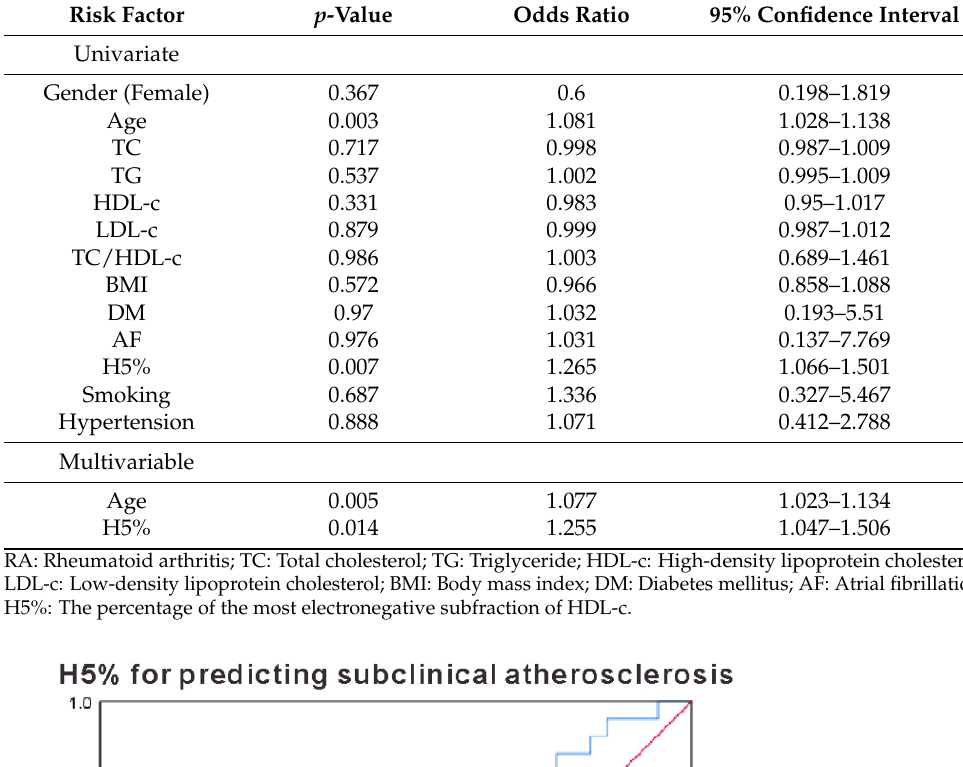
Table 2. Logistic regression analysis of traditional cardiovascular risk factors, RA-related factors, and plasma H5% with the presence of subclinical atherosclerosis in 69 patients with RA. p -Value